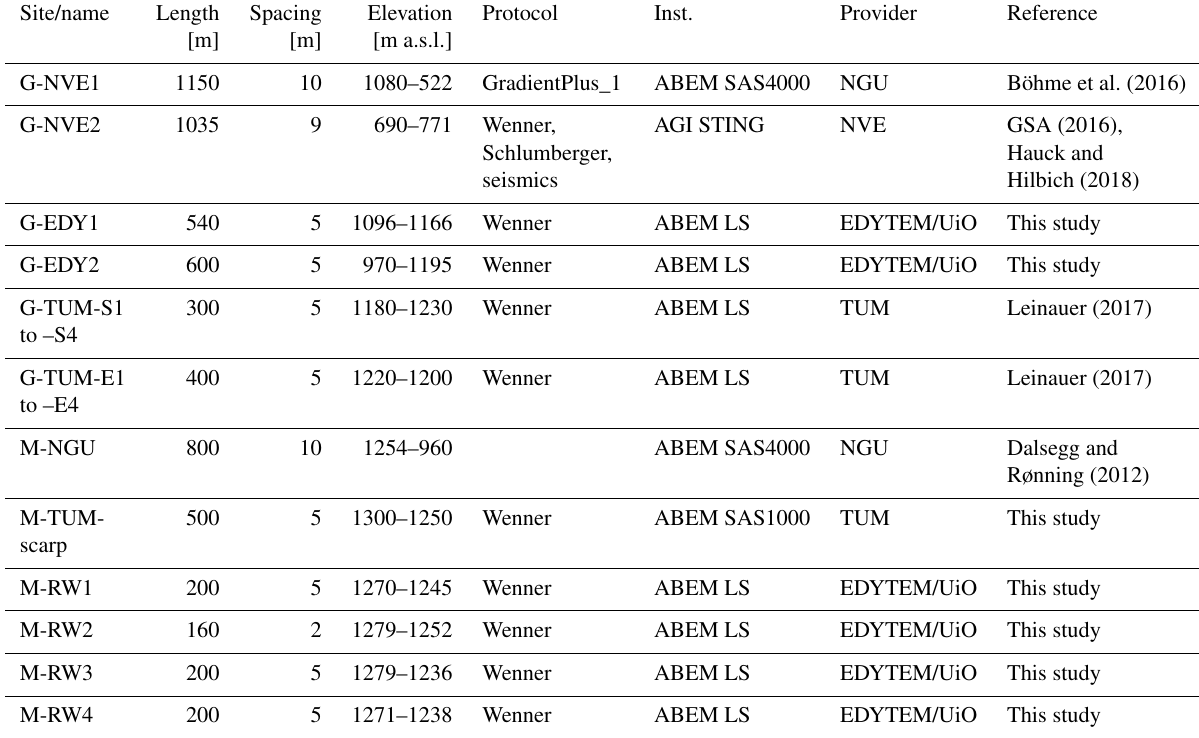
Table 1. Electrical resistivity tomograms included in this study. Provider refers to the institution involved in the ERT survey. For G-NVE2 co-located ERT and seismic profiles were re-analysed by Hauck and Hilbich